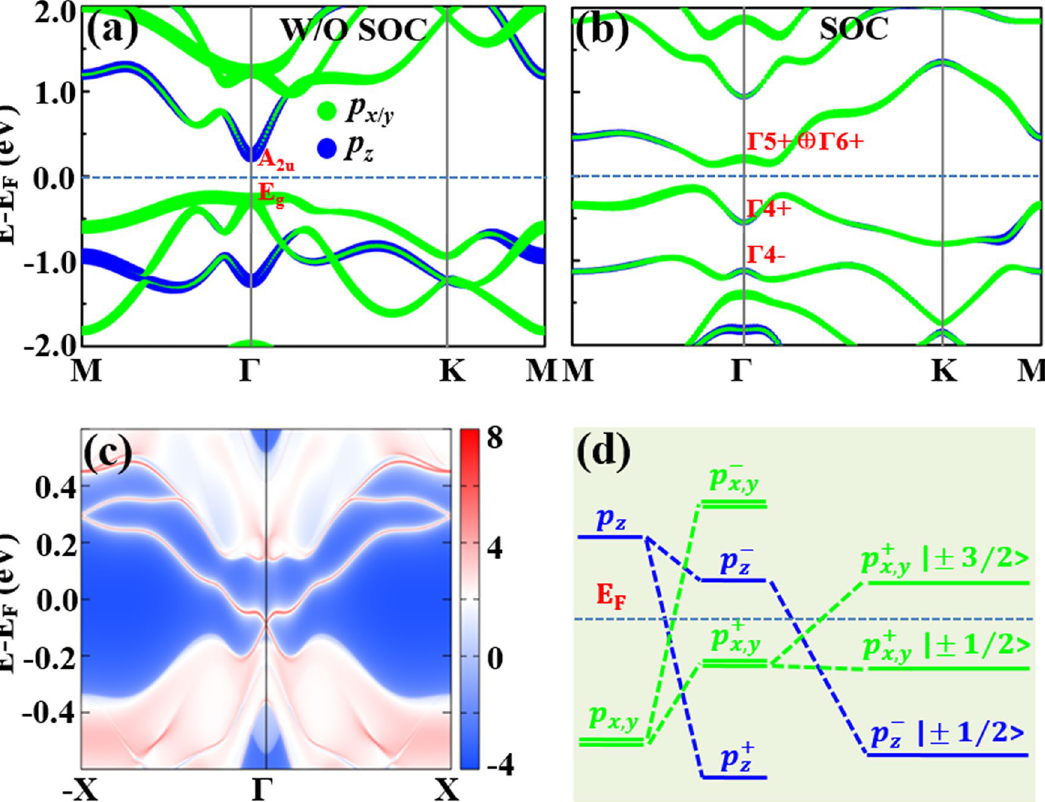
Figure 2. Orbital-resolved band structures of the poloniumene without ( a ) and with ( b ) SOC, where the calculated irreducible representations of the energy bands around the E F are also displayed. The label + ( −) denotes the even (odd) parity. ( c ) Helical edge states of the poloniumene. ( d ) Schematic diagram of the energy level evolution for the p x , y and p z orbitals around the Γ